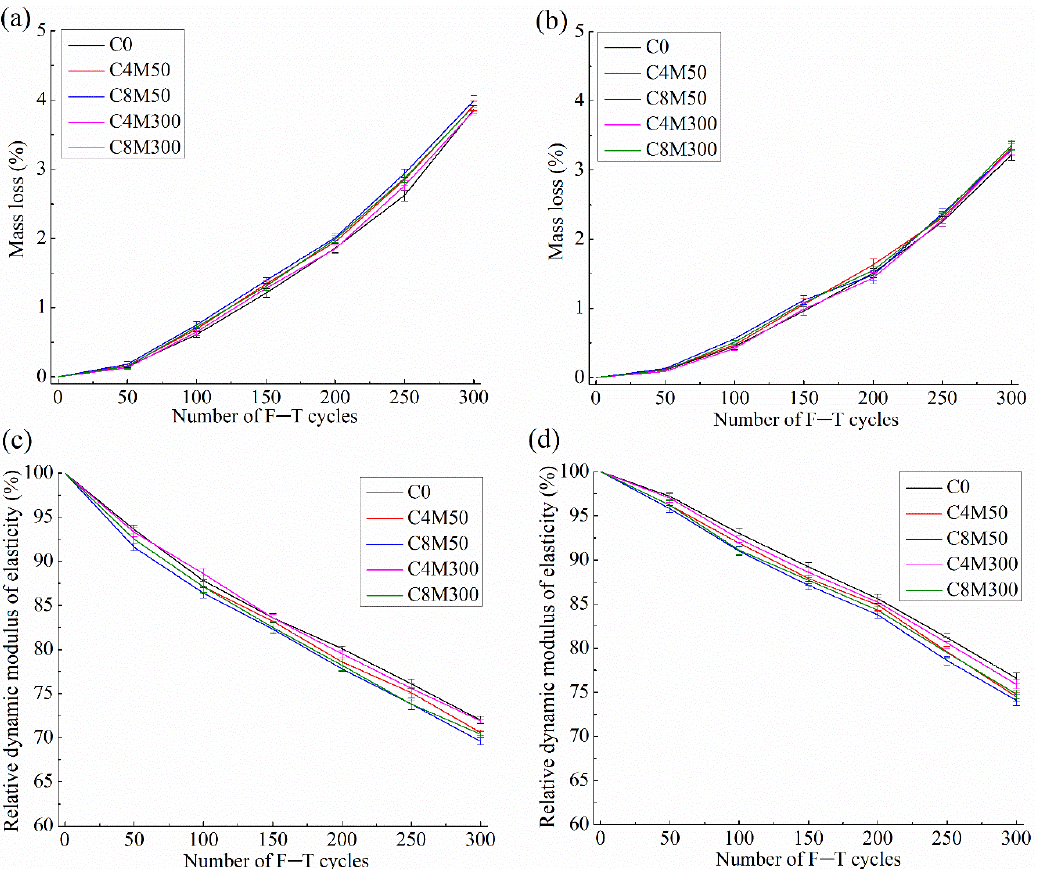
Figure 2. F – T resistance results of concrete; ( a ) 28-day mass loss, ( b ) 180-day mass loss, ( c ) 28-day relative dynamic elastic modulus and ( d ) 180-day relative dynamic elastic modulus.